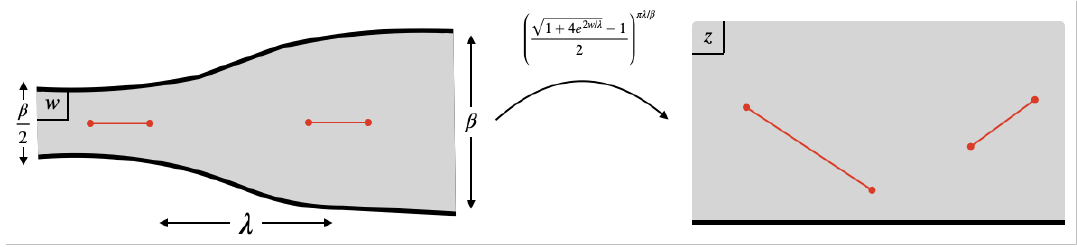
Figure 5 . The inhomogeneous strip is shown on the left which smoothly interpolates between width (cid:12)= 2 and (cid:12) with interpolation region of length (cid:21) . The red dots represent operator insertions and the thick black lines represent conformal boundaries. In our setup, we are generally concerned with the con(cid:12)guration in which the intervals lie on either side of the interpolation region such that they initially observe di(cid:11)erent e(cid:11)ective